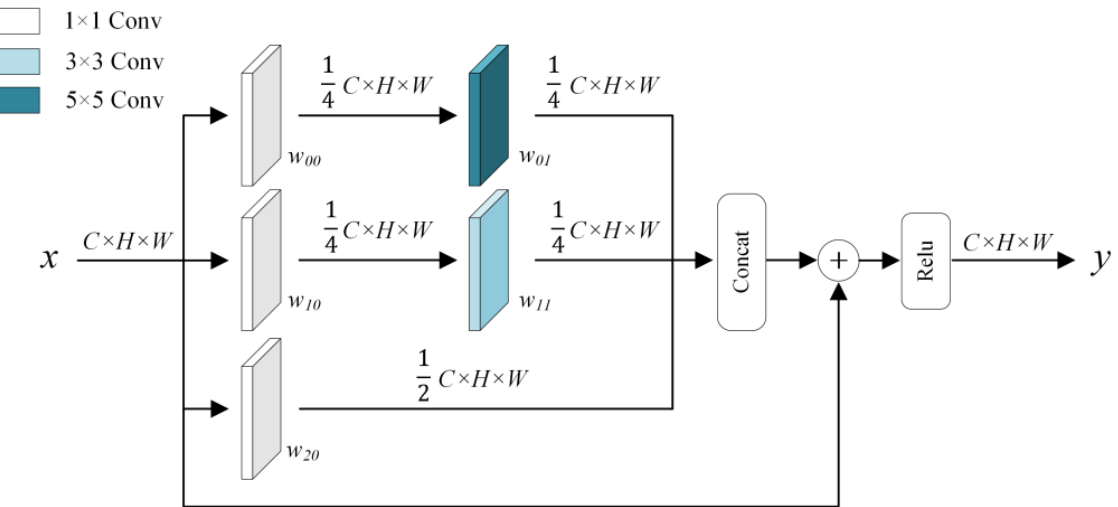
Figure 3. The structure of MSC, which adopts convolution operation with different kernel sizes and fuses after residual connection to extract and refine features in receptive fields of various sizes. During detection, the model mainly relies on the backbone network to extract local feature information from SAR images. However, the large down-sampling factors involved in extraction may mean the model misses small-scale ships. In addition, the model is unable to capture sufficient global information due to the small actual receptive field of the convolutional neural network. To improve the capability of small ship detection in SAR images and minimize the leakage of small targets, we propose a Feature Transformer Module (FTM) that can capture rich global and contextual information, as shown in Figure